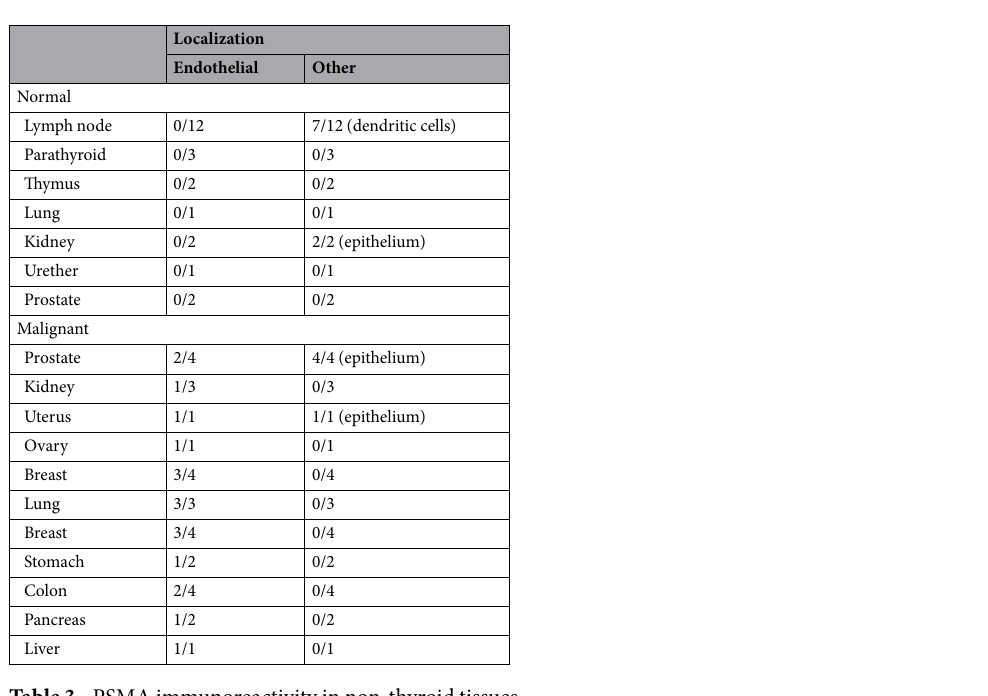
Table 3. PSMA immunoreactivity in non-thyroid